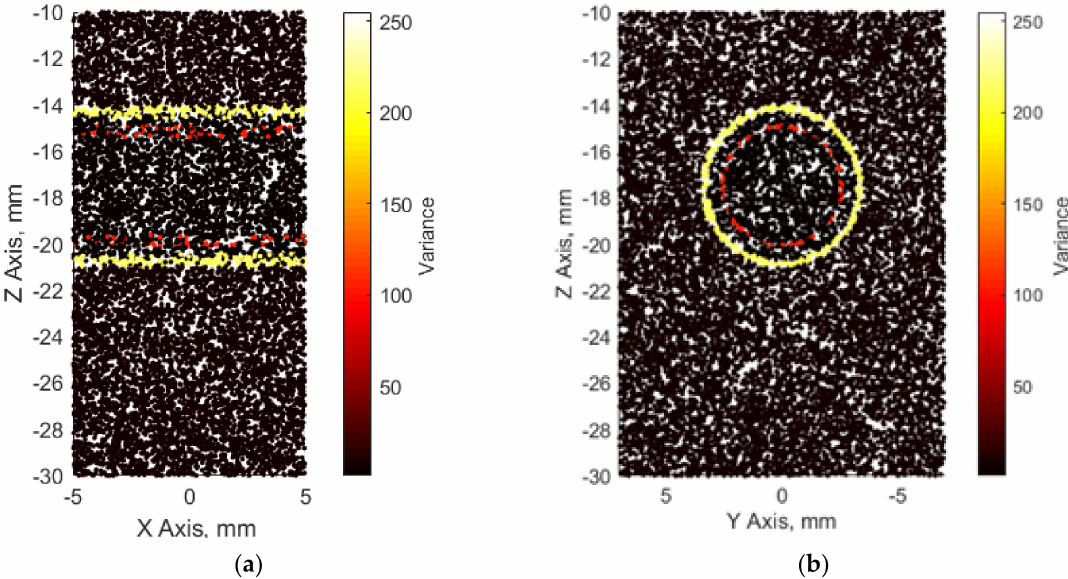
Figure 4. 3D map of scatterers from different viewpoints representing the artery model: ( a ) longitudi- nal; ( b )